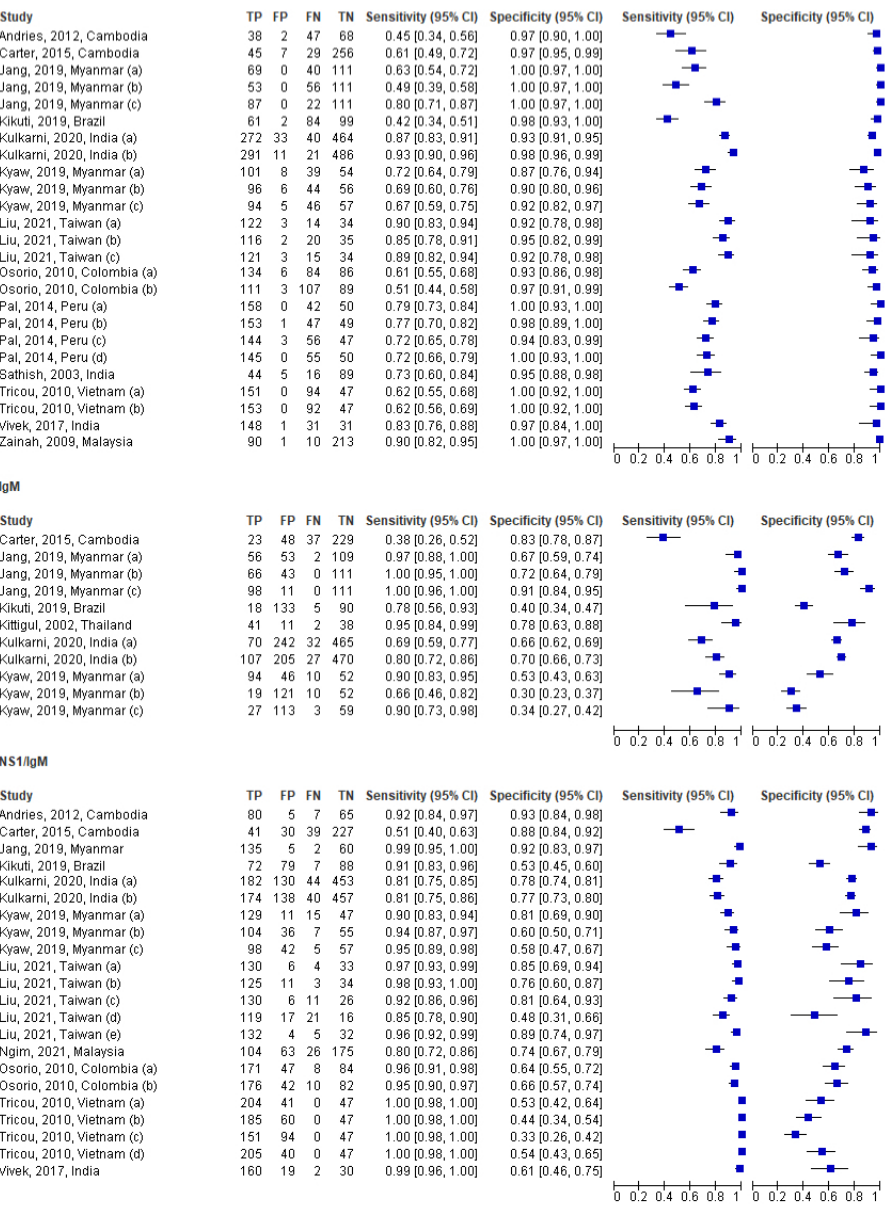
Figure 3. Summary forest plot for IgM (only), NS1 (only), and NS1/IgM tests in the acute phase [25–39].